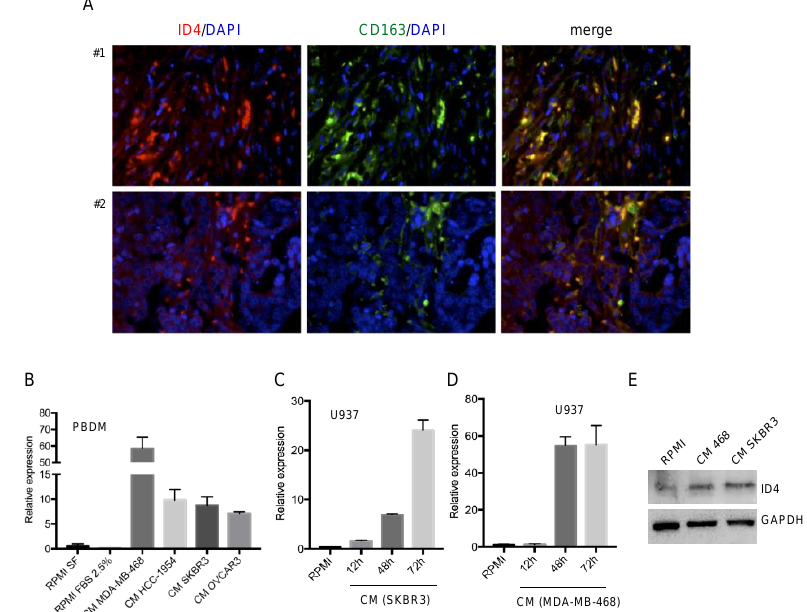
Figure 1. ID4 expression is induced in macrophages cultured with conditioned media from breast and ovarian cancer cells. A. ID4 mRNA expression evaluated by RT-qPCR in macrophages, obtained from differentiation of peripheral blood-derived monocytes (PBDM), cultured with RPMI serum free (SF), RPMI 2.5% FBS or conditioned medium (CM) from the indicated breast (MDA-MB-468, HCC-1954, SKBR3) and ovarian (OVCAR3) cancer cells. Relative expression has been assessed normalizing over GAPDH levels. Data are presented as mean of the expression observed in two donors ± standard error. B-C. ID4 mRNA expression in differentiated U937 cells, cultured with RPMI medium or with CM from the indicated breast cancer cell lines for the indicated time. D. ID4 protein expression analyzed by western blot in U937 cells cultured in RPMI medium or in CM from the indicated breast cancer cell lines for 24h. E. ID4 and CD163 protein expression evaluated by immunohistochemistry on two breast cancer FFPE tissue sections.